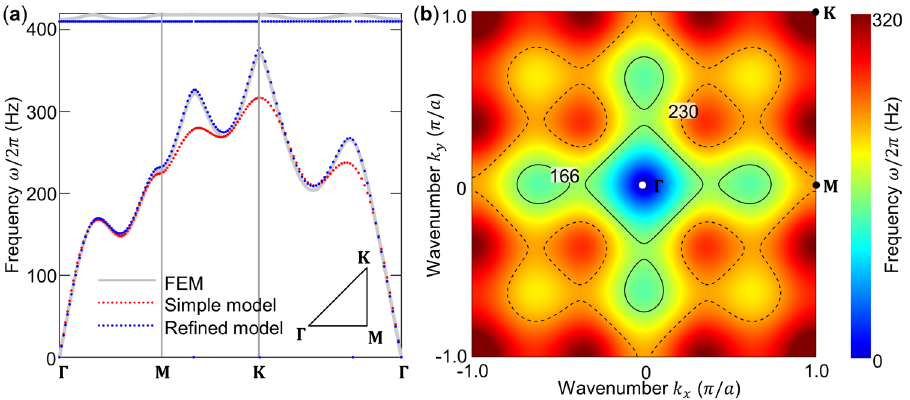
Fig. 3 Calculated phonon dispersion relation for the metamaterial structure shown in Fig. 1, i.e., for N = 3 beyond-nearest-neighbor interactions only. a Tour through the fi rst Brillouin zone (see inset) of the 2D square lattice with lattice constant a . The gray curve is obtained by numerical fi nite-element- method (FEM) calculations. The analytical results of the simple discrete model are shown by the red curve. Here, only the lowest band occurs. The results of the re fi ned analytical model are shown by the blue dots. These almost completely overlap with the numerical calculations. The agreement with the simple discrete model is qualitatively very good, especially for the principal directions. The parameters for the gray and blue data are given in Fig. 1. The ¼ 27 : 9Nm (cid:4) 1 , and K ¼ 17 : 7Nm (cid:4) 1 . b Frequency as obtained from used parameters for the simple discrete model are: M ¼ ρ V c ¼ 9 : 3 ´ 10 (cid:4) 5 g ; K 3 1